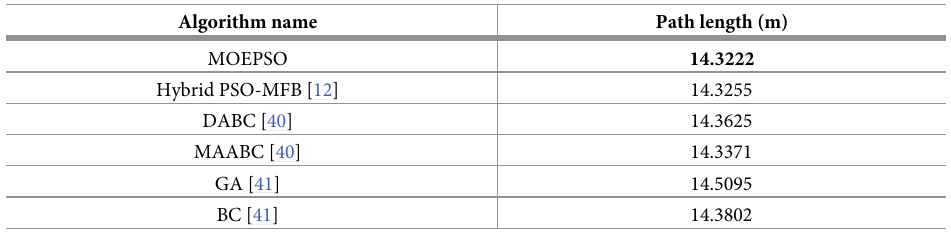
Table 9. Path planning results in the static environment (4